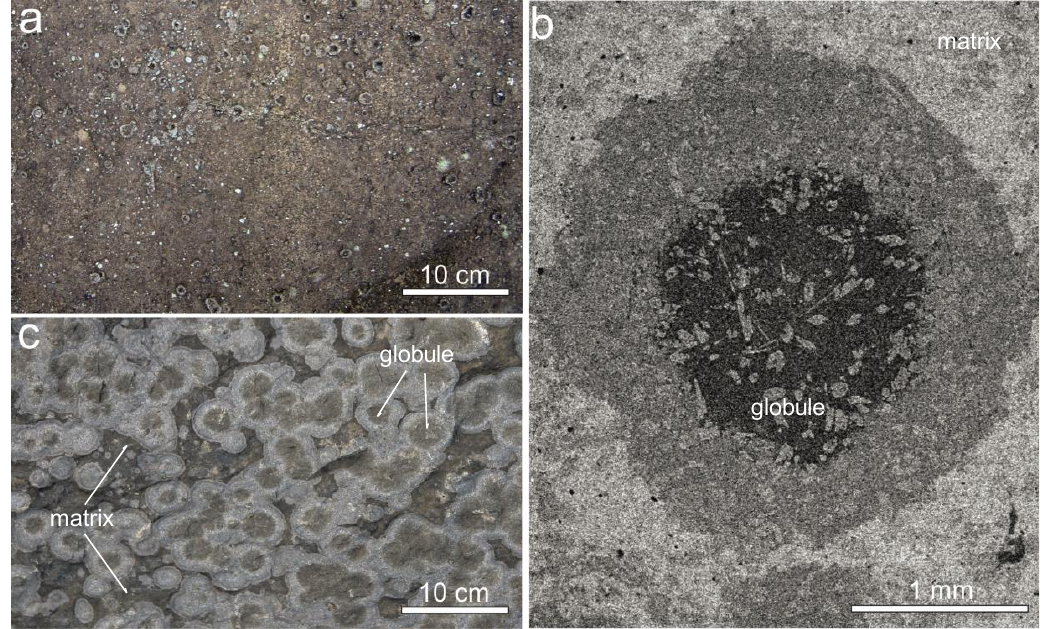
Figure 2. Representative field photographs of the massive ( a ) and variolitic ( b ) lavas and a backscattering electron image of a globule from the variolitic lava ( c ).